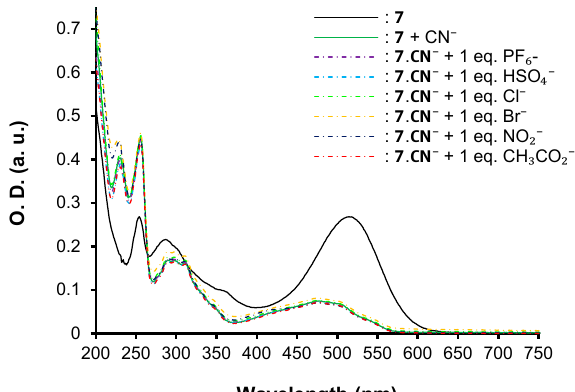
Figure 10. Competitive UV–vis titration assays upon addition of 1 equivalent of the studied anions to 7.CN − .